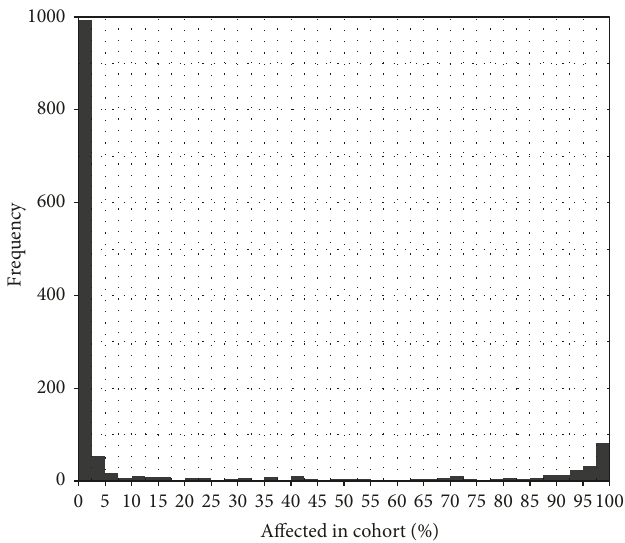
Figure 6: Highly methylated gene promoters in the dataset. Almost 200 gene promoters are highly methylated in 90% of the AML patients. We checked the distribution of those genes across the chromosomes in Figure